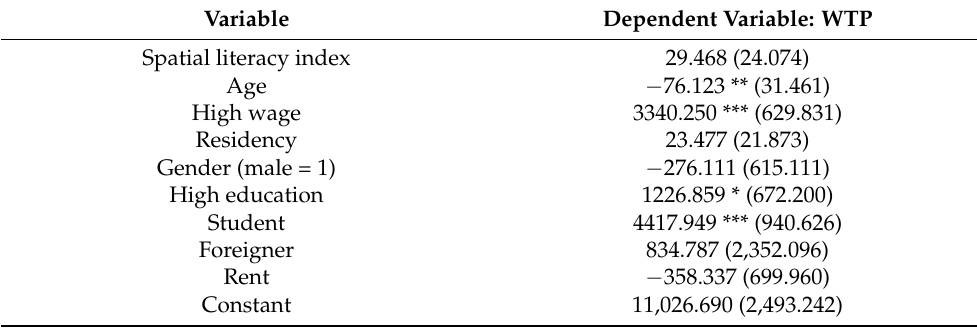
Table 7. Ordinary Least Square model results for willingness to pay (WTP) for forest resource improve- ment in Bogot á , Colombia. Standard errors of the coefficient estimates are reported in